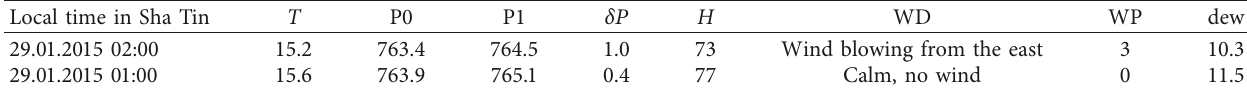
Table 3: Meteorological